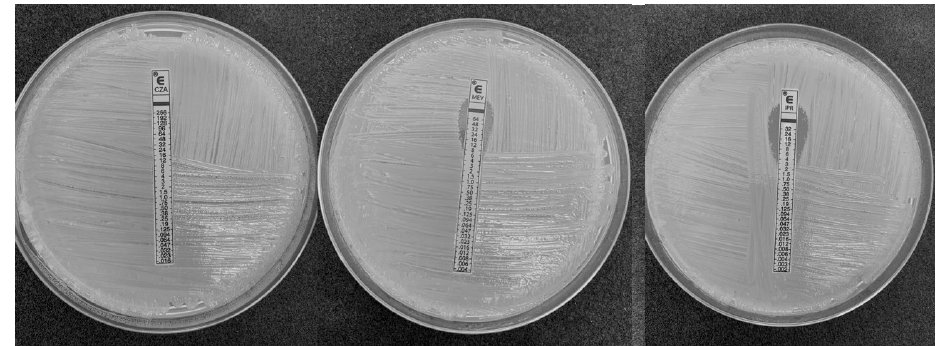
Figure 1. Results of E-test for β -lactam/ β -lactamase inhibitor combinations. Genetic analysis revealed that the strain had a genome size of 5,767,106 bp. It belonged to sequence type (ST) 512 and carried the wzi-154 capsular polysaccharide synthesis (CPS) gene, capsular locus KL107, and lipopolysaccharide O locus O2afg. Resistome analysis highlighted the presence of 23 resistance genes conferring resistance to 9 different antibi- otic classes: aminoglycosides, fluoroquinolones, macrolides, chloramphenicol, rifampicin, sulfonamides, tetracyclines, trimethoprim, and carbapenems (including bla KPC-31 and bla OXA-181 genes) (Tables 2 and 3). Table 2. Antimicrobial resistance genes found by Whole Genome